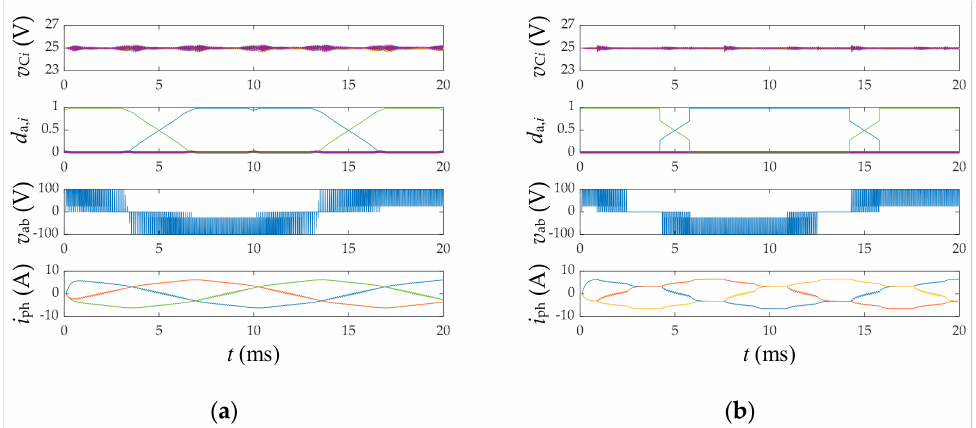
Figure 8. Simulation results for the three-phase NPC DC–AC conversion system of Figure 4, with n = 5, operated with the proposed VVPWM strategy formulation and hbc = 0.98, under two differ- ent modulation index values m corresponding to the overmodulation region. ( a ) m = 1.01 (OMI); ( b ) m = 1.07 (OMII).